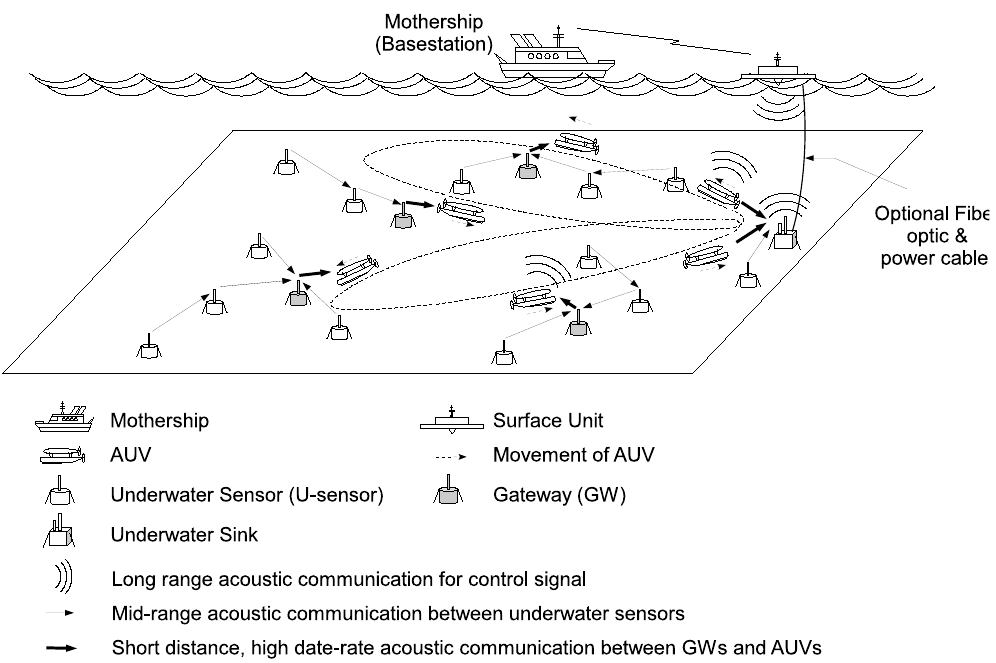
Figure 1. Underwater Acoustic Sensor Network with multiple